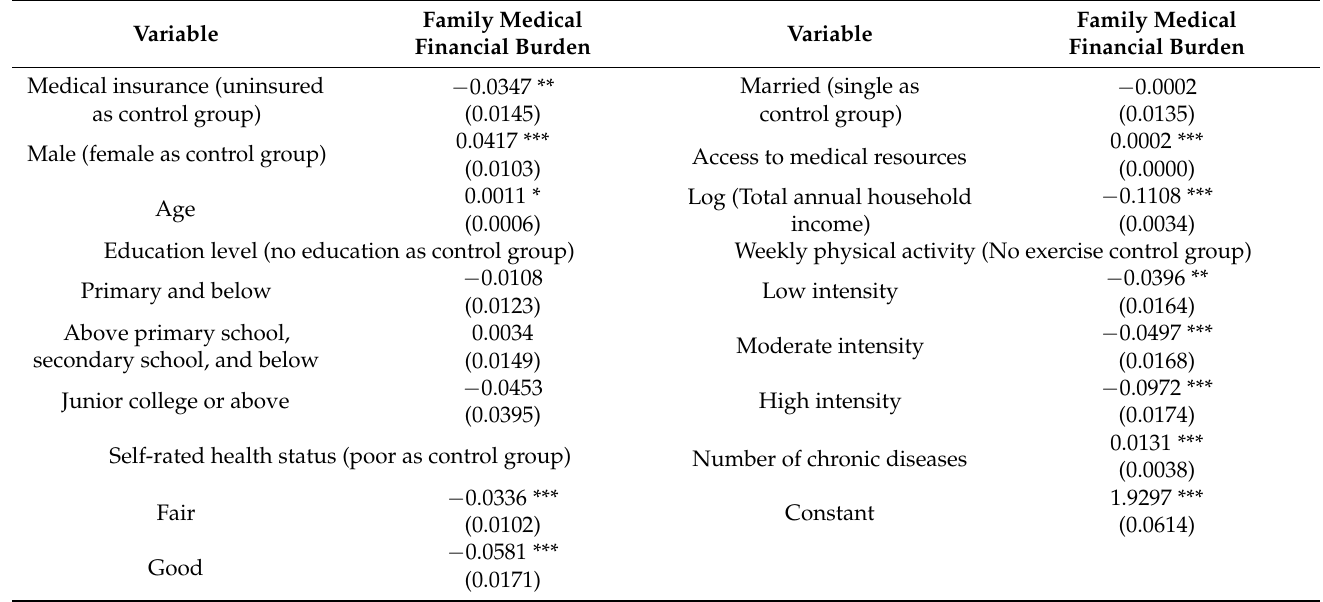
Table 3. Research on the negative effect of medical insurance on the family medical financial burden.